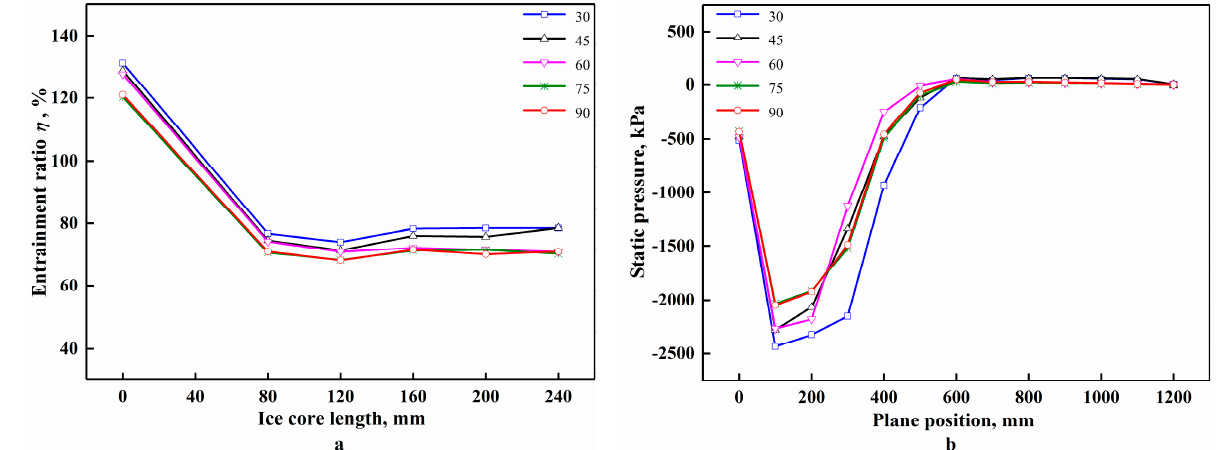
Figure 6. Results of different helical angles for drill bits with flushing nozzles closed: ( a ) influence of helical angles on entrainment ratio; ( b ) pressure distribution of central passage.